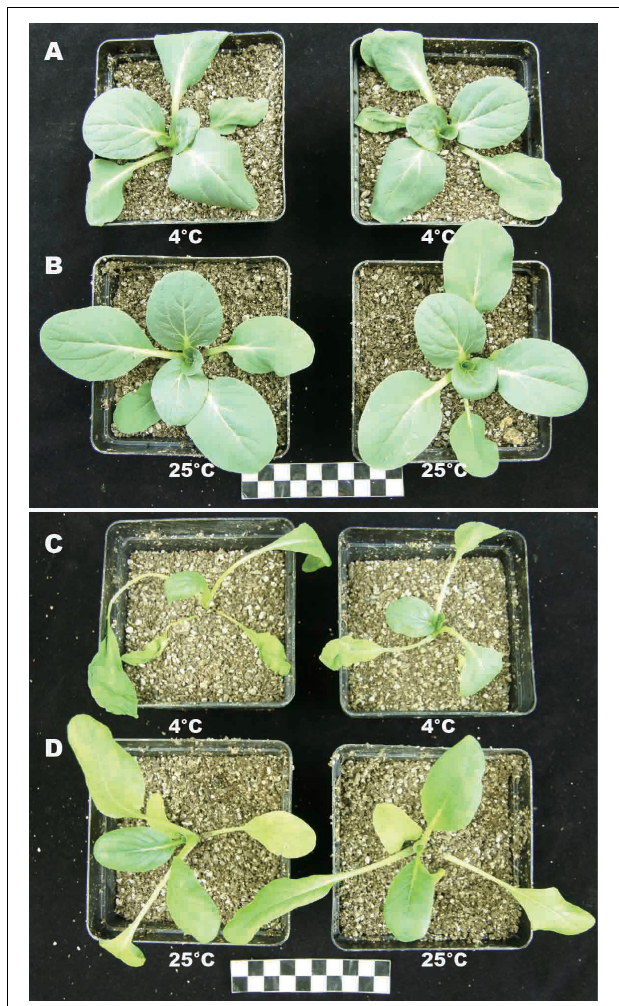
FIGURE 1 | Phenotype of BcL.1 and BcL.2 under cold stress. Approximately 30-day-old seedlings were subjected to cold stress (4 ◦ C for 6 h); plants grown under normal condition (22 ◦ C) for 6 h were used as control. (A) BcL.1-4 . (B) BcL.1-25 . (C) BcL.2-4 . (D) BcL.2-25